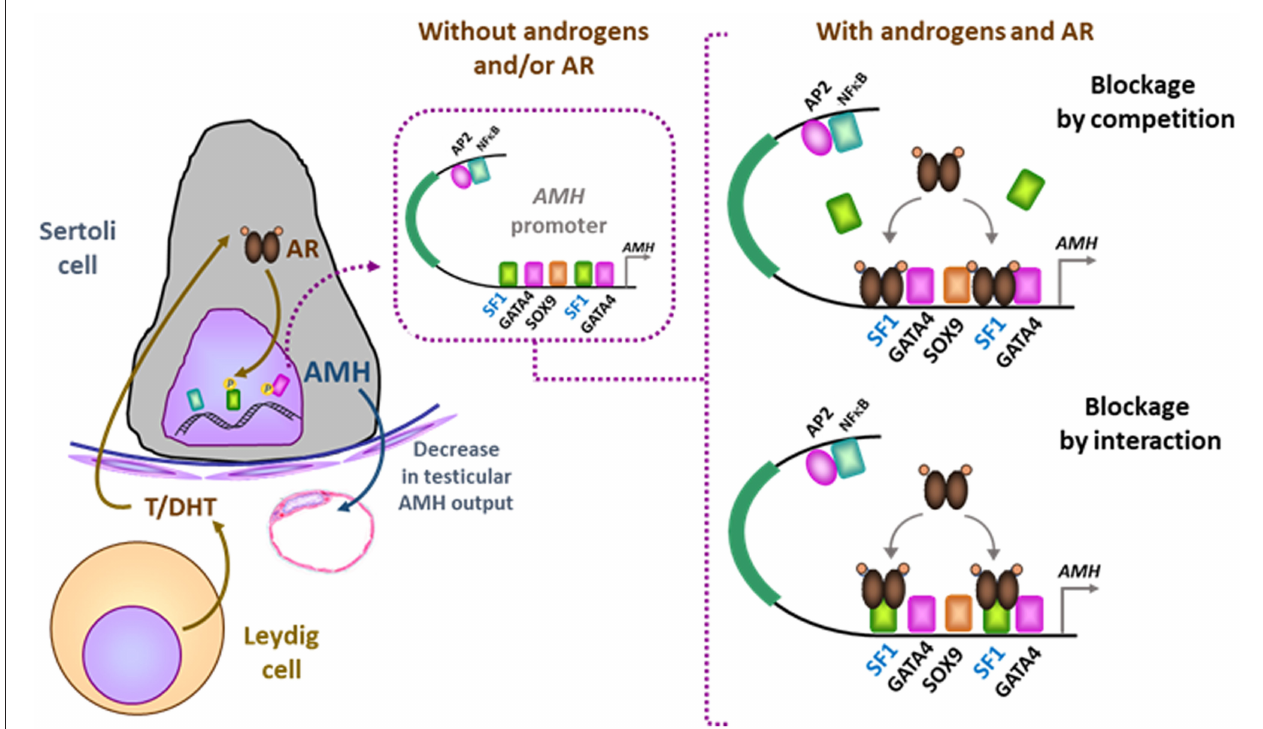
FIGURE 2 | Downregulation of AMH production in testicular Sertoli cells by androgens. In the absence of androgens (e.g., normal childhood and DSD with impaired androgen production) or androgen receptor (AR, e.g., normal fetal and neonatal periods and DSD due to androgen insensitivity syndromes), SF1 binds to its response elements on the AMH promoter and increases AMH transcription. When androgen action on the AR is effective in the Sertoli cell (e.g., at puberty), the ligand-activated AR could either block SF1 binding to the AMH promoter (blockage by competition) or interact with site-bound-SF1 and prevent it from exerting its stimulatory effect on AMH promoter (blockage by interaction). Modified with permission from ( 17). Copyright © The Author(s) 2018.